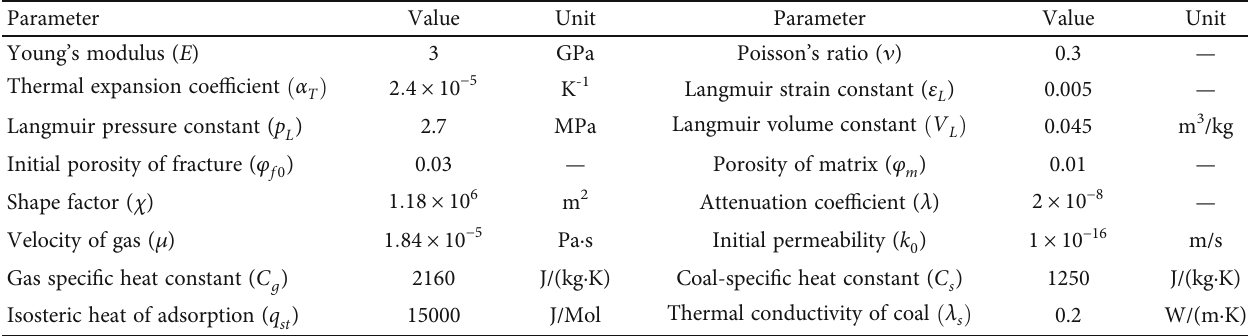
Table 4: Key parameters of the numerical model.